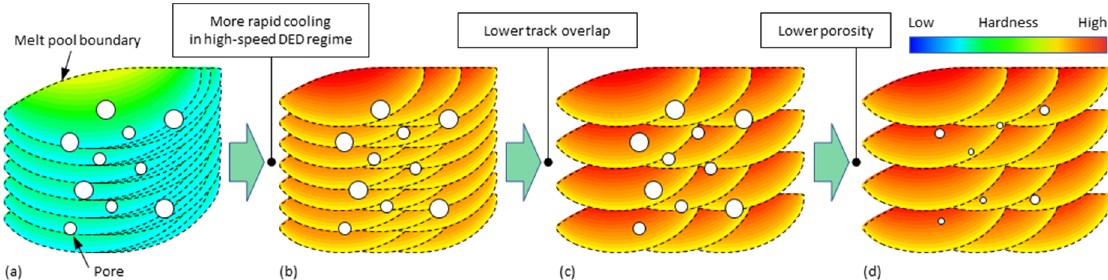
Figure 1. Approach to improve the mechanical performance of AlMgScZr alloys in DED as illustrated by the hardness distribution over the sample cross-section obtained by overlapping tracks deposited under different conditions: ( a ) conventional DED, ( b ) high-speed DED with high track overlap rate, ( c ) high-speed DED with decreased track overlap rate, ( d ) with further decreased porosity.